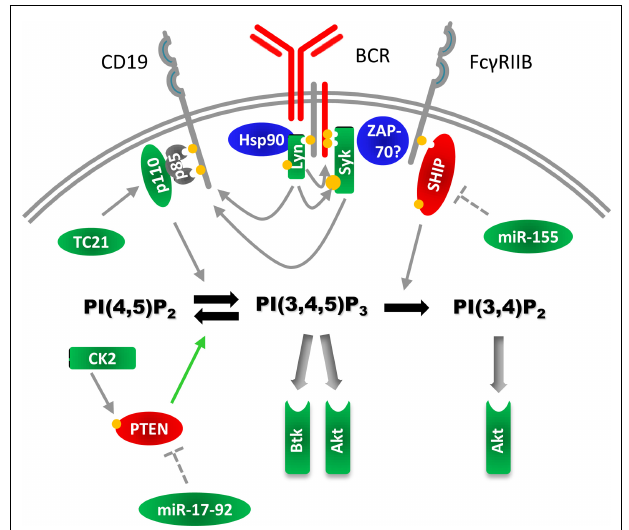
FIGURE 4 |Alterations in the PI3K pathway in malignant B cells. In malignant B cells, several pathway players have been found to be over-expressed or hyper-phosphorylated.The figure illustrates signaling molecules whose expression, phosphorylation or activity are reported to be altered in malignant B cells (green indicates increased activity, red indicates reduced activity). Altered molecules discussed in the text include p110 subunits, Lyn, Syk, Btk, Akt,TC21, and the BCR signaling chain CD79b. The formation of a non-physiological complex between Lyn and Hsp90 in malignant B cells is indicated. Increased expression of microRNA species that target PTEN and SHIP are reported to reduce expression of these phosphatases. Moreover, the PTEN kinase CK2 is reported to be over-expressed which may diminish PTEN activity. ZAP-70 is expressed in some B cell malignancies, however the impact on the PI3K pathway is currently not